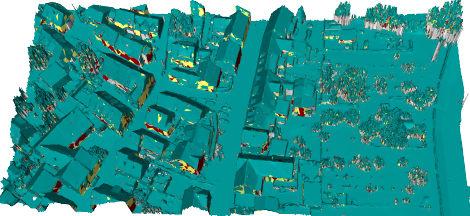
Figure 6. Color-coded threshold levels per face (level 1: green , level 2: yellow , level 3: red ). Non-associated faces are marked in gray. Best viewed digitally.